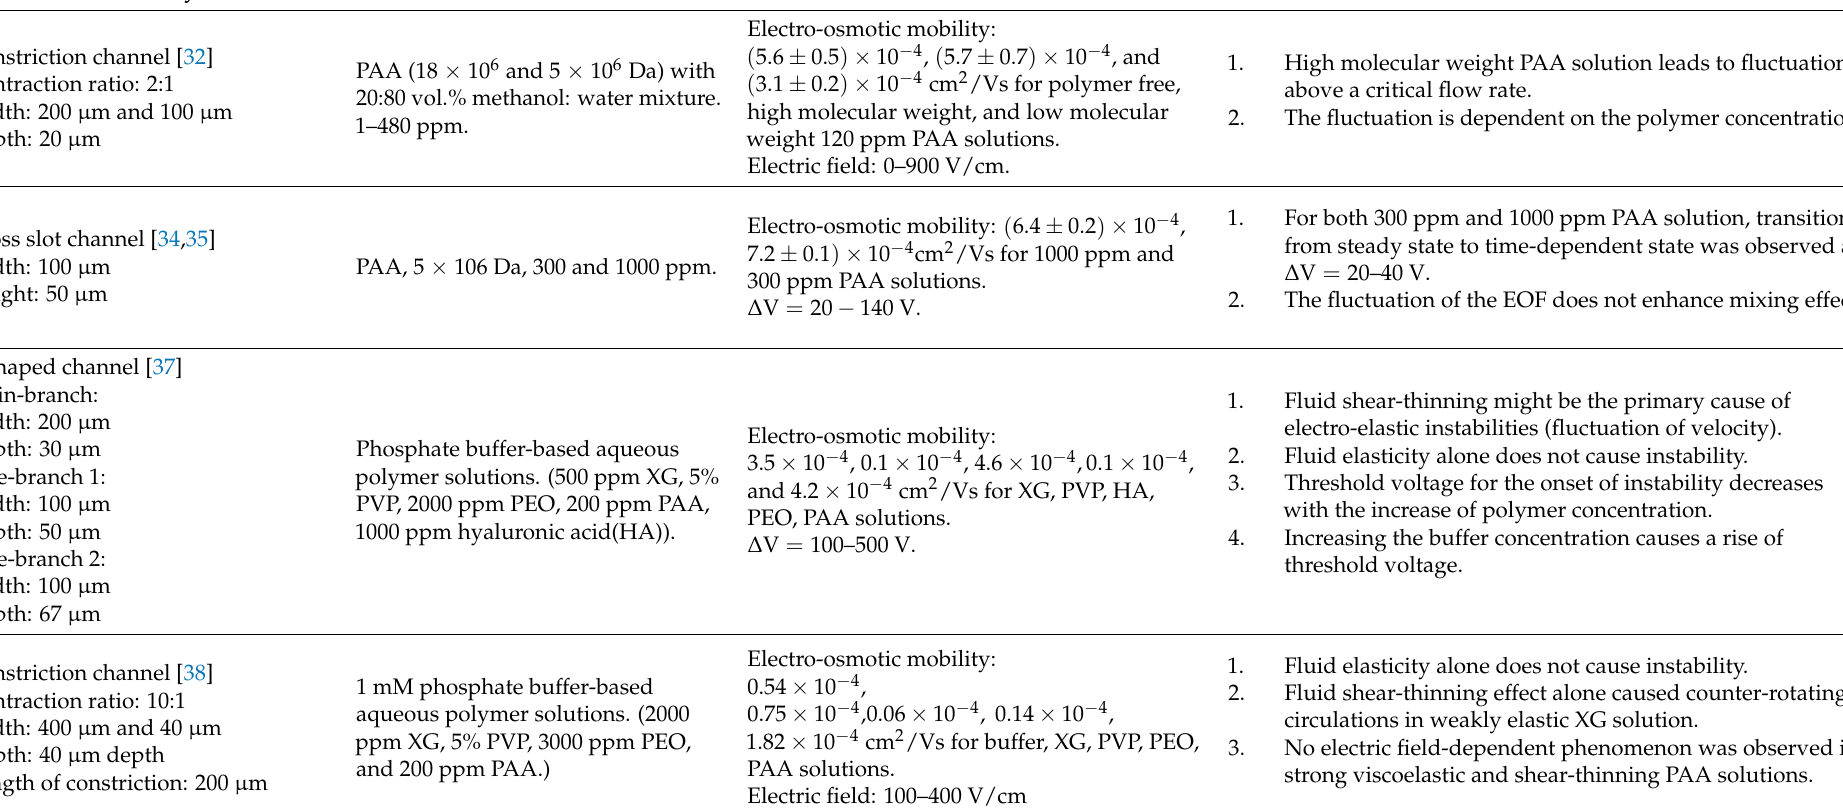
Table A1. Summary of current studies on elastic instabilities of viscoelastic EOF. Electrical Parameters